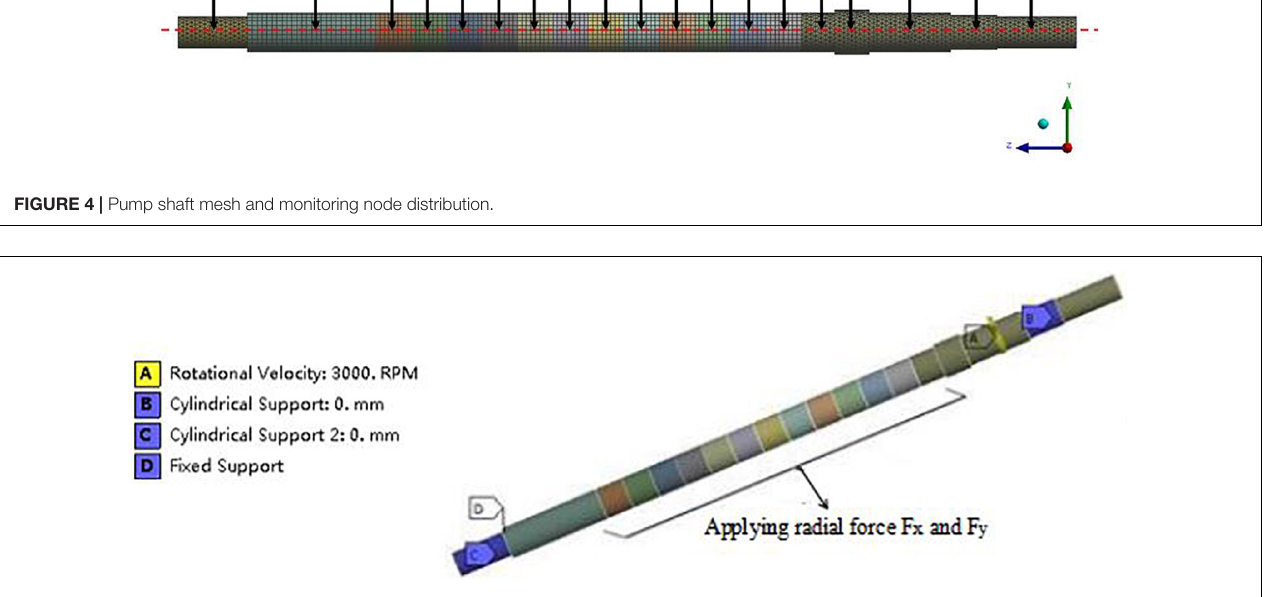
FIGURE 5 | Setting diagram for transient dynamics analysis of pump shaft.